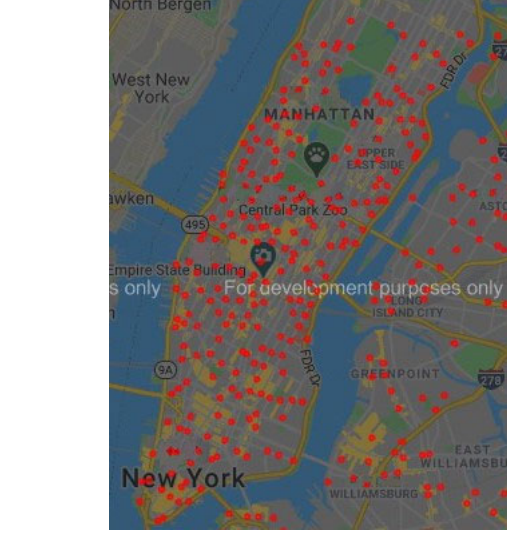
Figure 1. Two main approaches to processing traffic data. ( a ) Grid ‐ based approach. ( b ) Station ‐ based approach.